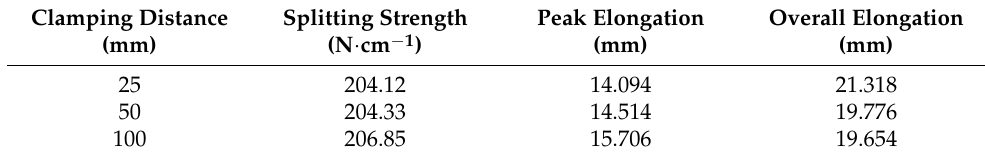
Table 6. Splitting test results of the